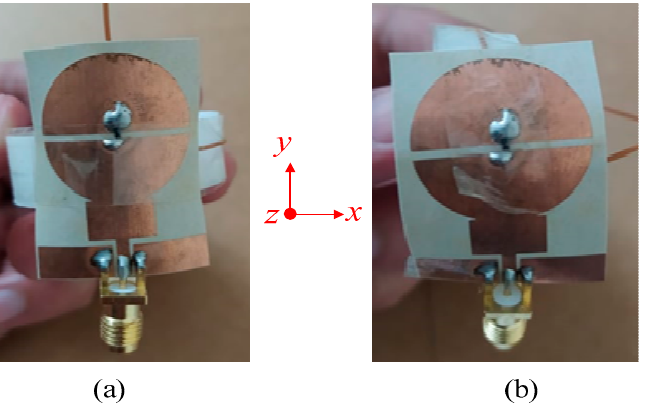
Figure 8. Antenna under conformal condition: ( a ) bending along the x -axis and ( b ) bending along the y -axis.